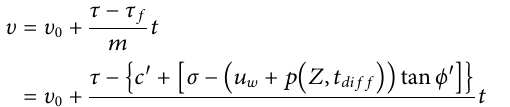
Frontiers in Earth Science |